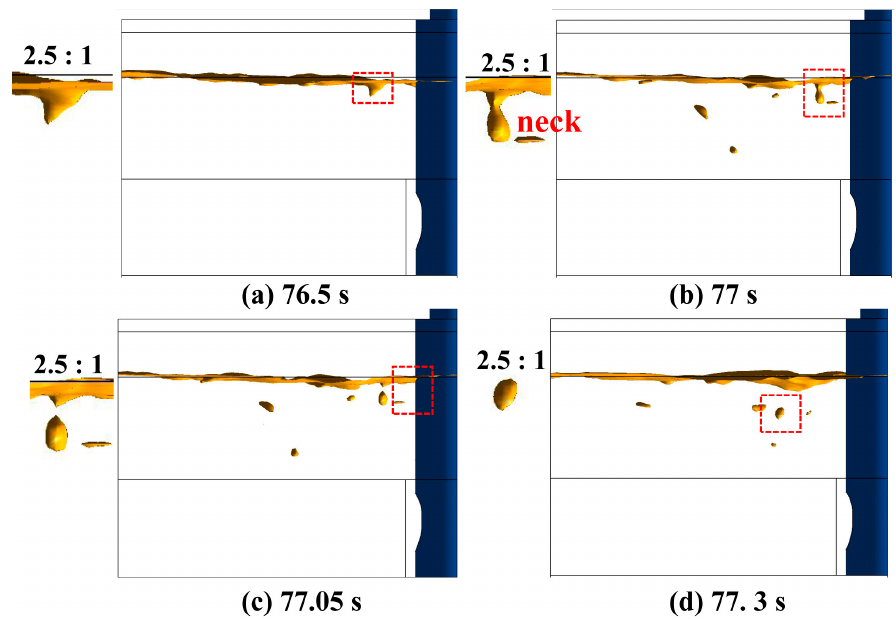
Figure 7. Transient deformation of slag layer after ( a ) 76.5 s, ( b ) 77 s, ( c ) 77.05 s, and ( d ) 77.3 s.